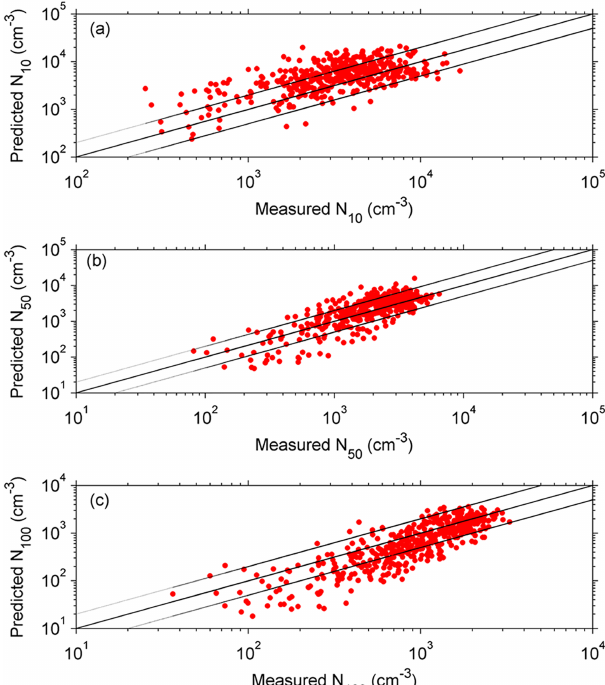
Figure 4. Comparison of predicted versus observed particle number concentrations (cm − 3 ) above 10, 50, and 100nm from the 16 mea- surement stations across Europe during 5 June–8 July 2012. Each point corresponds to a daily average value. Also shown are the 1:1, 2:1, and 1:2